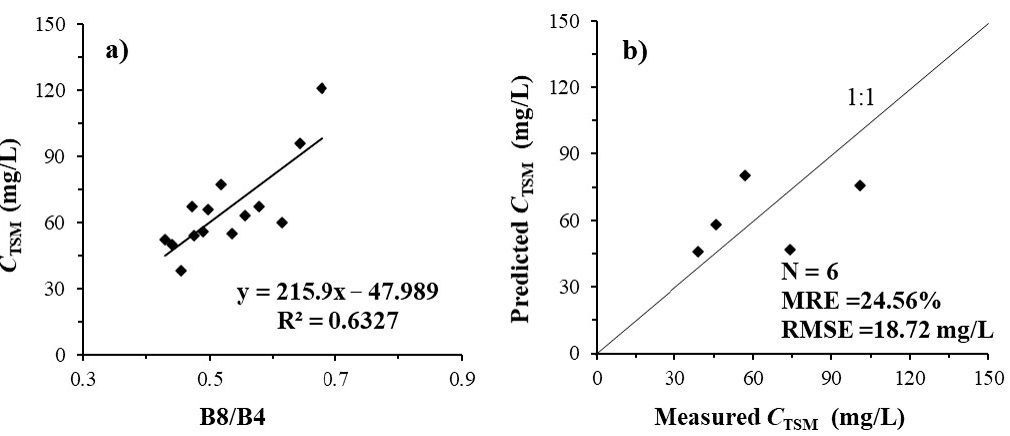
Figure 4. ( a ) The TSM concentration inversion model established by method 1, and ( b ) the accuracy evaluation of the model by verification samples.